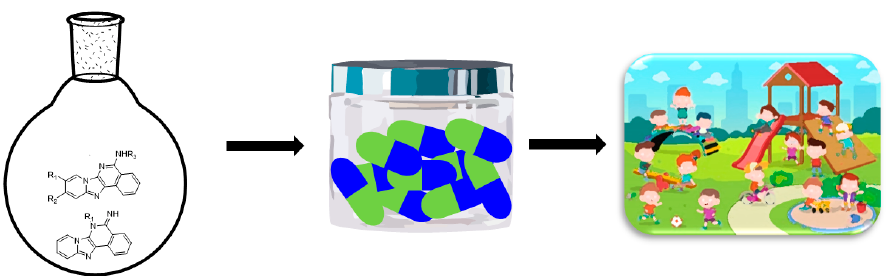
Figure 1. These potentially active molecules could become drug candidates for the protection of children and prevent pediatric cancer mortality.